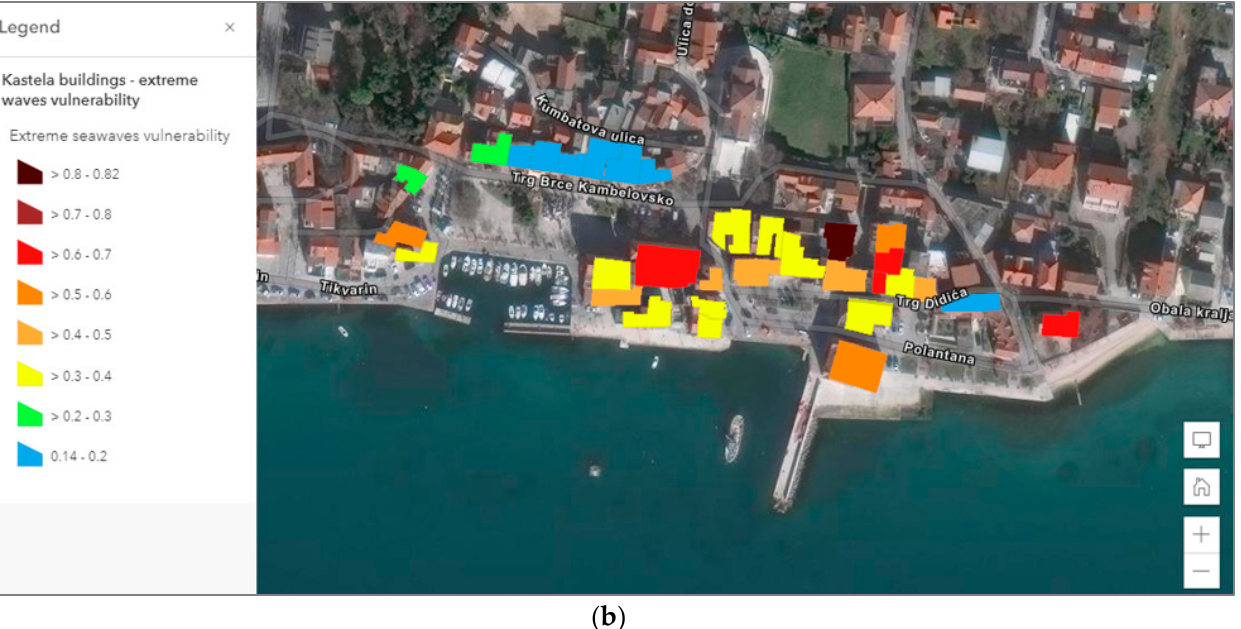
Figure 6. Vulnerability index of buildings for: ( a ) sea floods; ( b ) extreme sea waves.